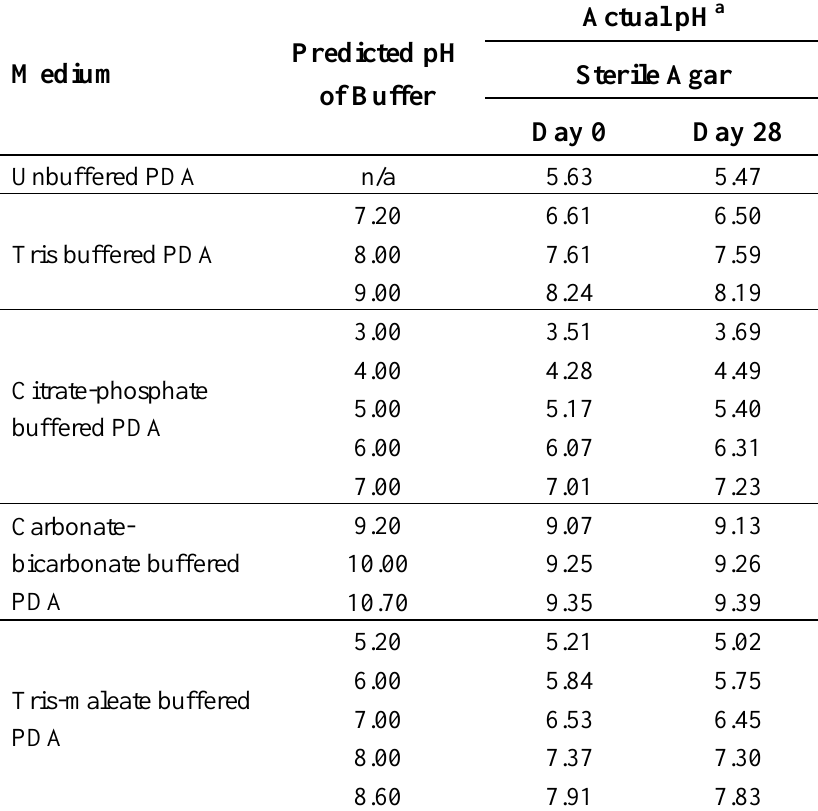
Table 1. pH measurements of sterile potato dextrose